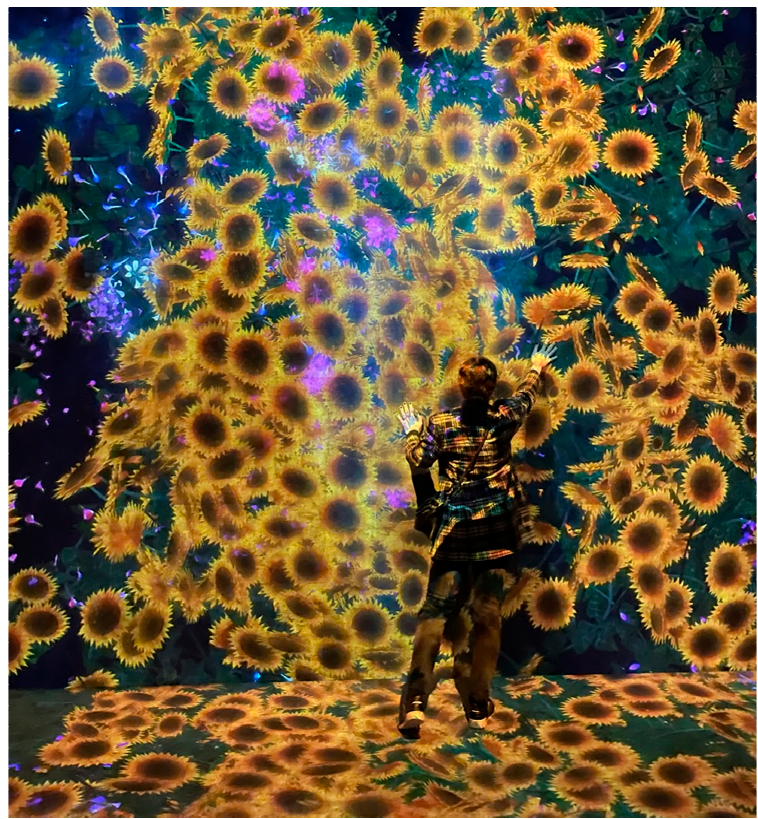
Figure 9. teamLab, Forest of Flowers and People: Lost, Immersed and Reborn (Summer), 2017/2021, Asian Art Museum of San Francisco; photograph by the author,